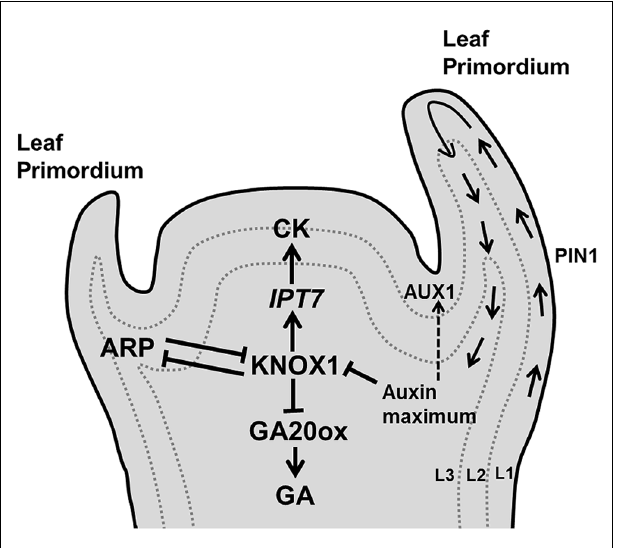
FIGURE 3 | Decision of leaf initiation. Accumulation peaks of auxin at the flank of the SAM through PIN1/AUX1 mediate polar auxin transport, triggers development of a primordium where KNOX1 plays key role in stem cell maintenance. Additionally, KNOX1 positively regulates CK whereas it negatively affects GA signaling through IPT7 and GA20 oxidases, respectively. Opposite to it, ARP regulates the emergence of a young primordium (pointed andT shaped arrows indicate positive and negative regulation,